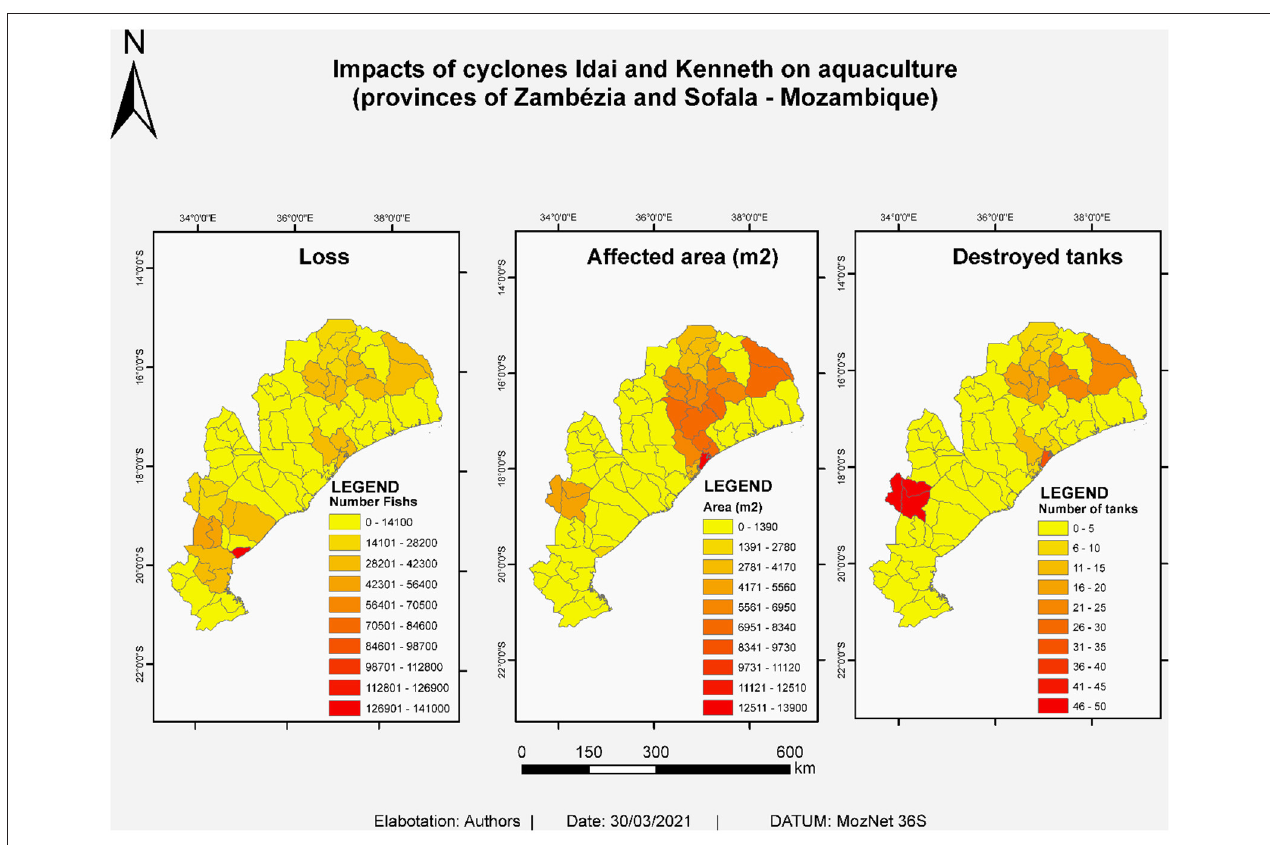
FIGURE 4 | Location of the impacted areas of the cyclones Idai and Kenneth in fisheries and aquaculture. Source: